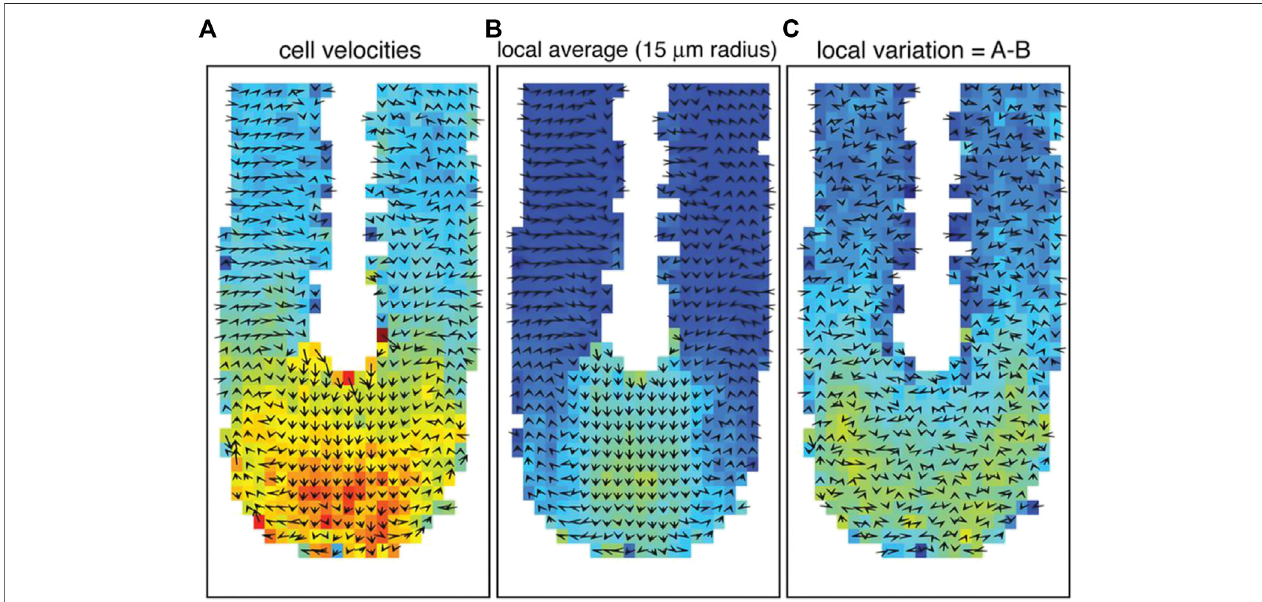
FIGURE 2 | Cell movement and tissue fl uidity in the zebra fi sh tailbud. (A) Vector map of cell velocities. (B) Local tissue velocity averaged over a 15 μ m radius. (C) Cell velocity variation from local tissue velocity. The color red represents higher velocities, and arrows indicate the averaged velocity vectors in 2D. The tip of the tailbud displays higher cell velocities, more local rearrangements, and proliferation, indicating an unjammed, fl uid-like state. High motility and proliferation are driving factors for unjamming tissues, as veri fi ed by Mongera et al. [10]. Images were taken and adopted from Lawton et al. [48], Copyright ID 1096693 –